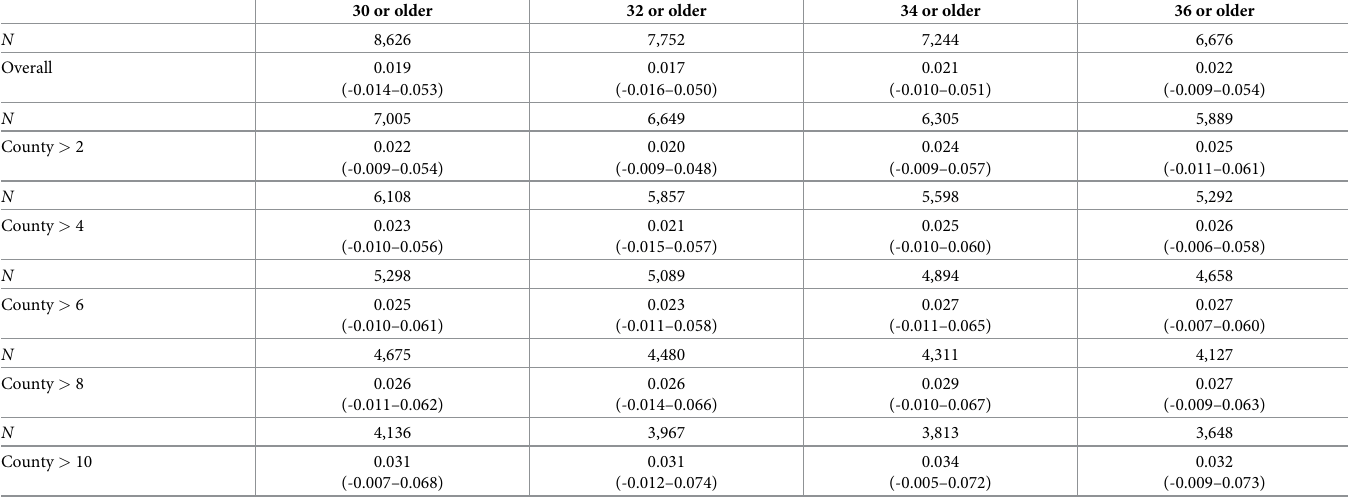
Table 3. The effects of neighborhood on health: Estimates of the percentage of the variation in adult self-rated health status attributable to county of residence, con- trolling for educational attainment. 30 or older